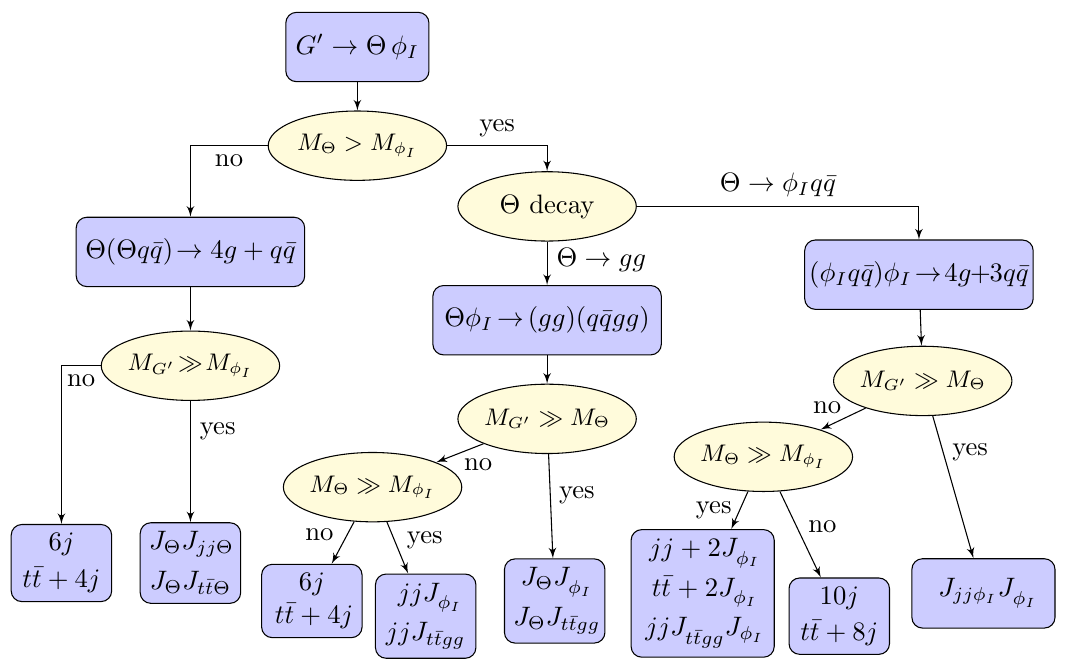
Figure 11 . Signatures of the ReCoM from the asymmetric pp G 0 (cid:2) (cid:30) I production, and the ! ! corresponding mass relations. For M (cid:30) < M (cid:2) , only the 1-loop (cid:30) I ggq (cid:22) q decays are included here. I ! The jet labelled by J (cid:2) has a 2-prong substructure, while J jj(cid:30) has a 6-prong substructure; both I have an invariant mass given by M (cid:2) . The jets labelled by J (cid:30) and J jj (cid:2) have a 4-prong substructure I and an M (cid:30) invariant mass. The boosted objects labelled by J and J have more complicated t (cid:22) tgg t (cid:22) t (cid:2) I . O (1 TeV) and M substructure and an M (cid:30) invariant mass. For M (cid:30) (cid:30) I < M (cid:2) , (cid:30) I is so long-lived I I that J (cid:30) and J may have a displaced t (cid:22) tgg I